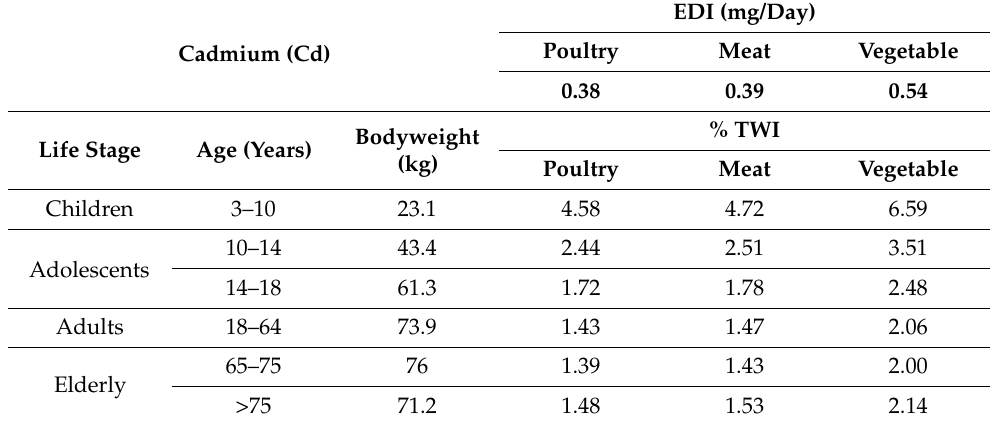
Table 7. Estimated daily intake and contribution percentage to the tolerable weekly Cd intake.